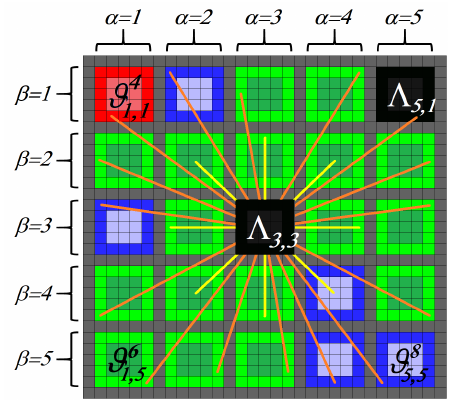
Figure 4. Example of patch Λ 3,3 with a grid ∆ of 5 ×